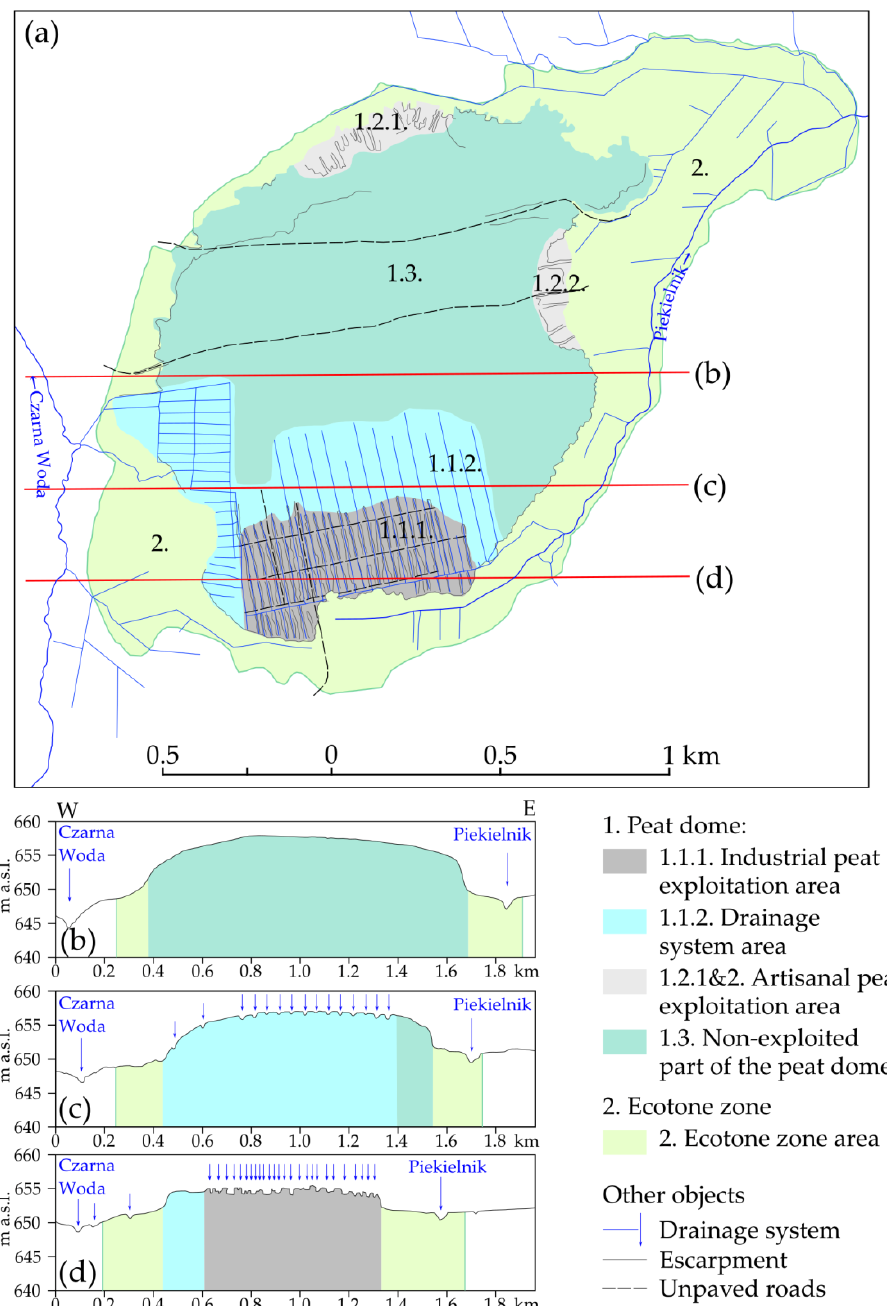
Figure 4. ( a ) Division of the Baligówka peat bog; ( b ) topographic profile along non-exploited part of the peat dome; ( c ) topographic profile along drainage system area; ( d ) topographic profile along industrial peat exploitation area.